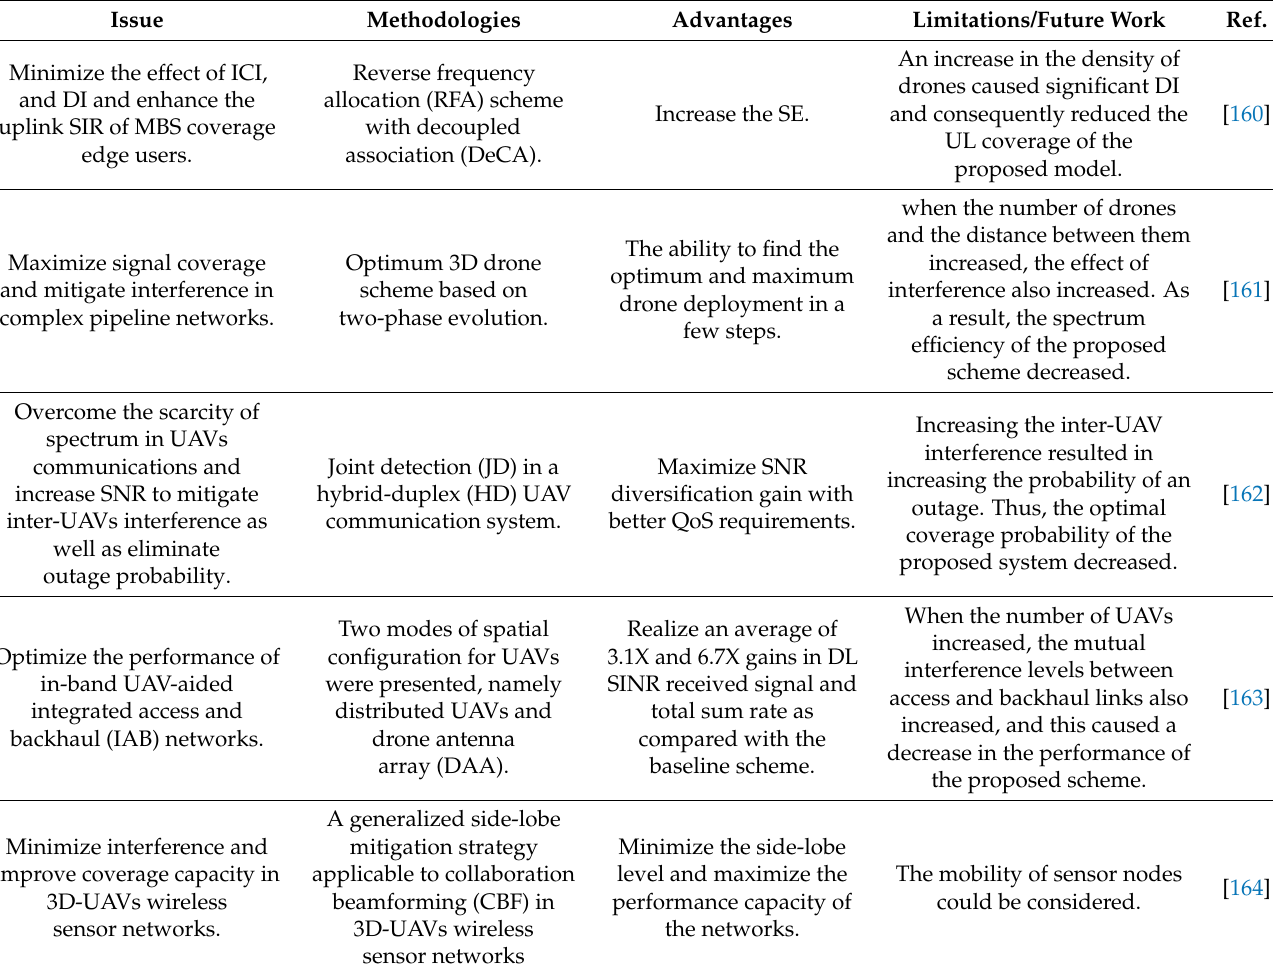
Table 5. The summary of previous studies of UAVs in the